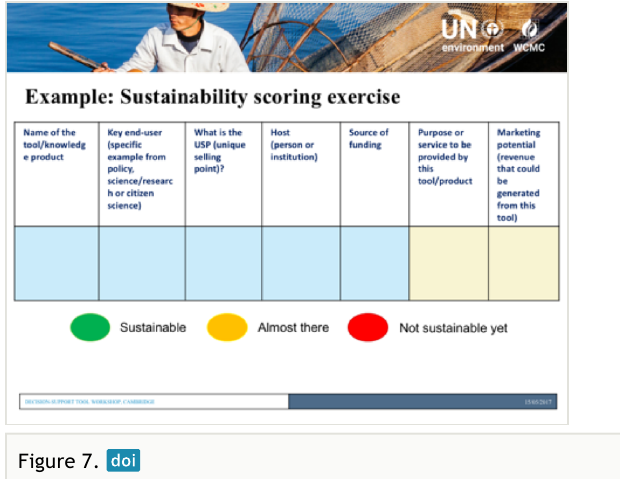
Sustainability scoring exercise (photo credit: